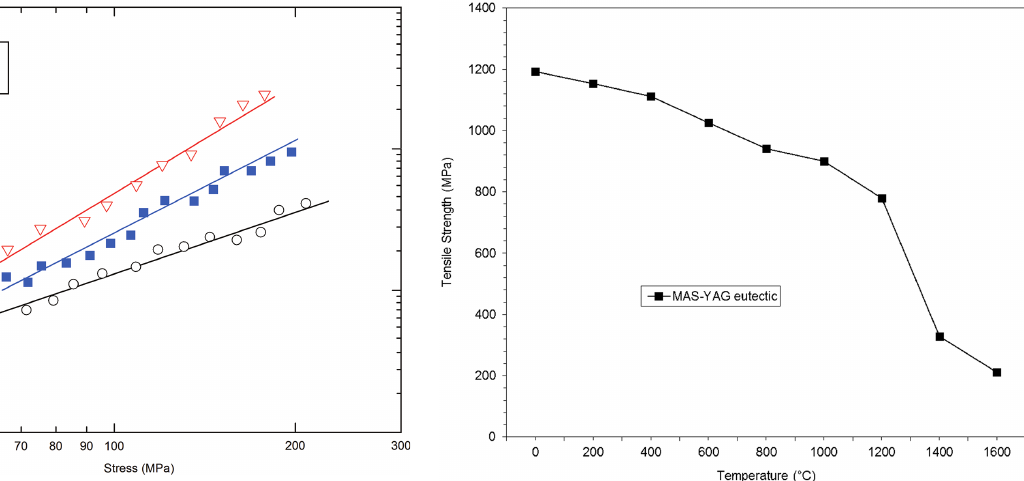
Figure 4: Temperature-dependent tensile strength of MgAl 2 O 4 - Y 3 Al 5 O 12